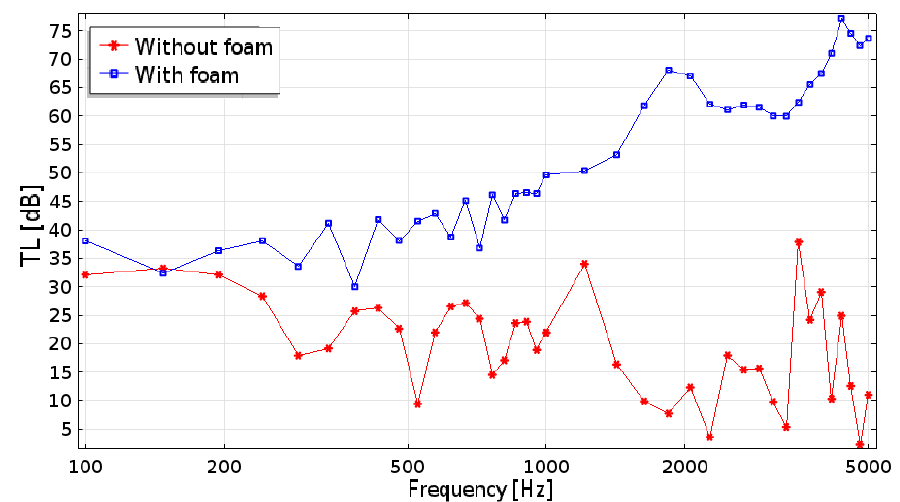
Figure 7. Transmission loss of the silencer for the primary flow.